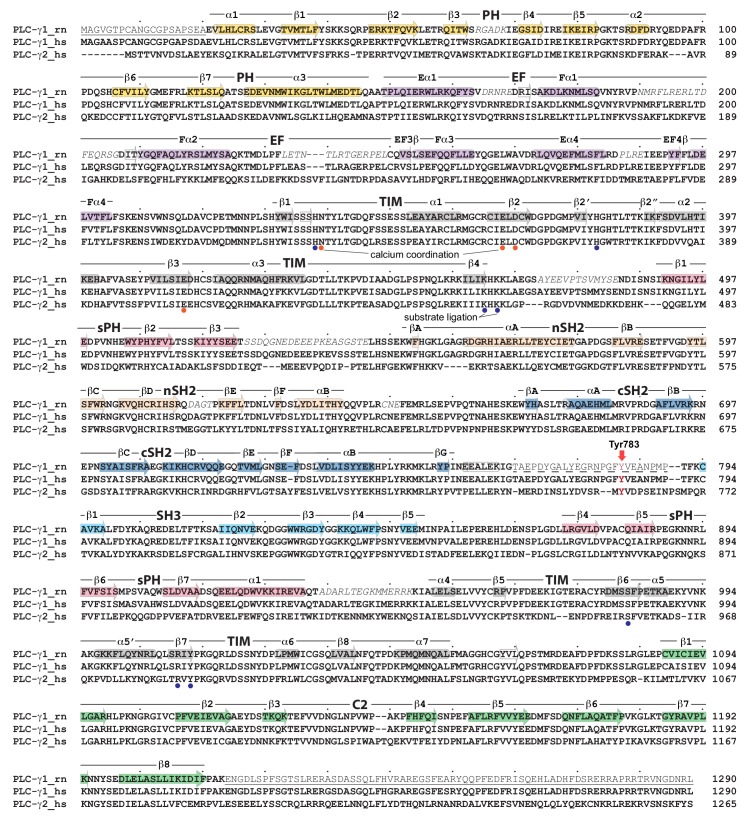
Primary sequence alignment of PLC-γ isozymes.The sequence of rat PLC-γ1 (PLC-γ1_rn, UniProt accession number P10686), human PLC-γ1 (PLC-γ1_hs, P19174), and human PLC-γ2 (PLC-γ2_hs, P16885) were aligned using ClustalW. Dots denote every 10th residue. Underlined residues were removed from the crystallization construct and the Δ25 deletion is highlighted with a dashed underline. Electron density was not observed for residues in italics. Secondary structure (α-helices, cylinders; β-strands, arrows) was assigned using DSSP. Tyr783 in PLC-γ1 and Tyr759 in PLC-γ2 are highlighted in red. Substrate ligation defined based on structural homology to PLC-δ1 and -β2.